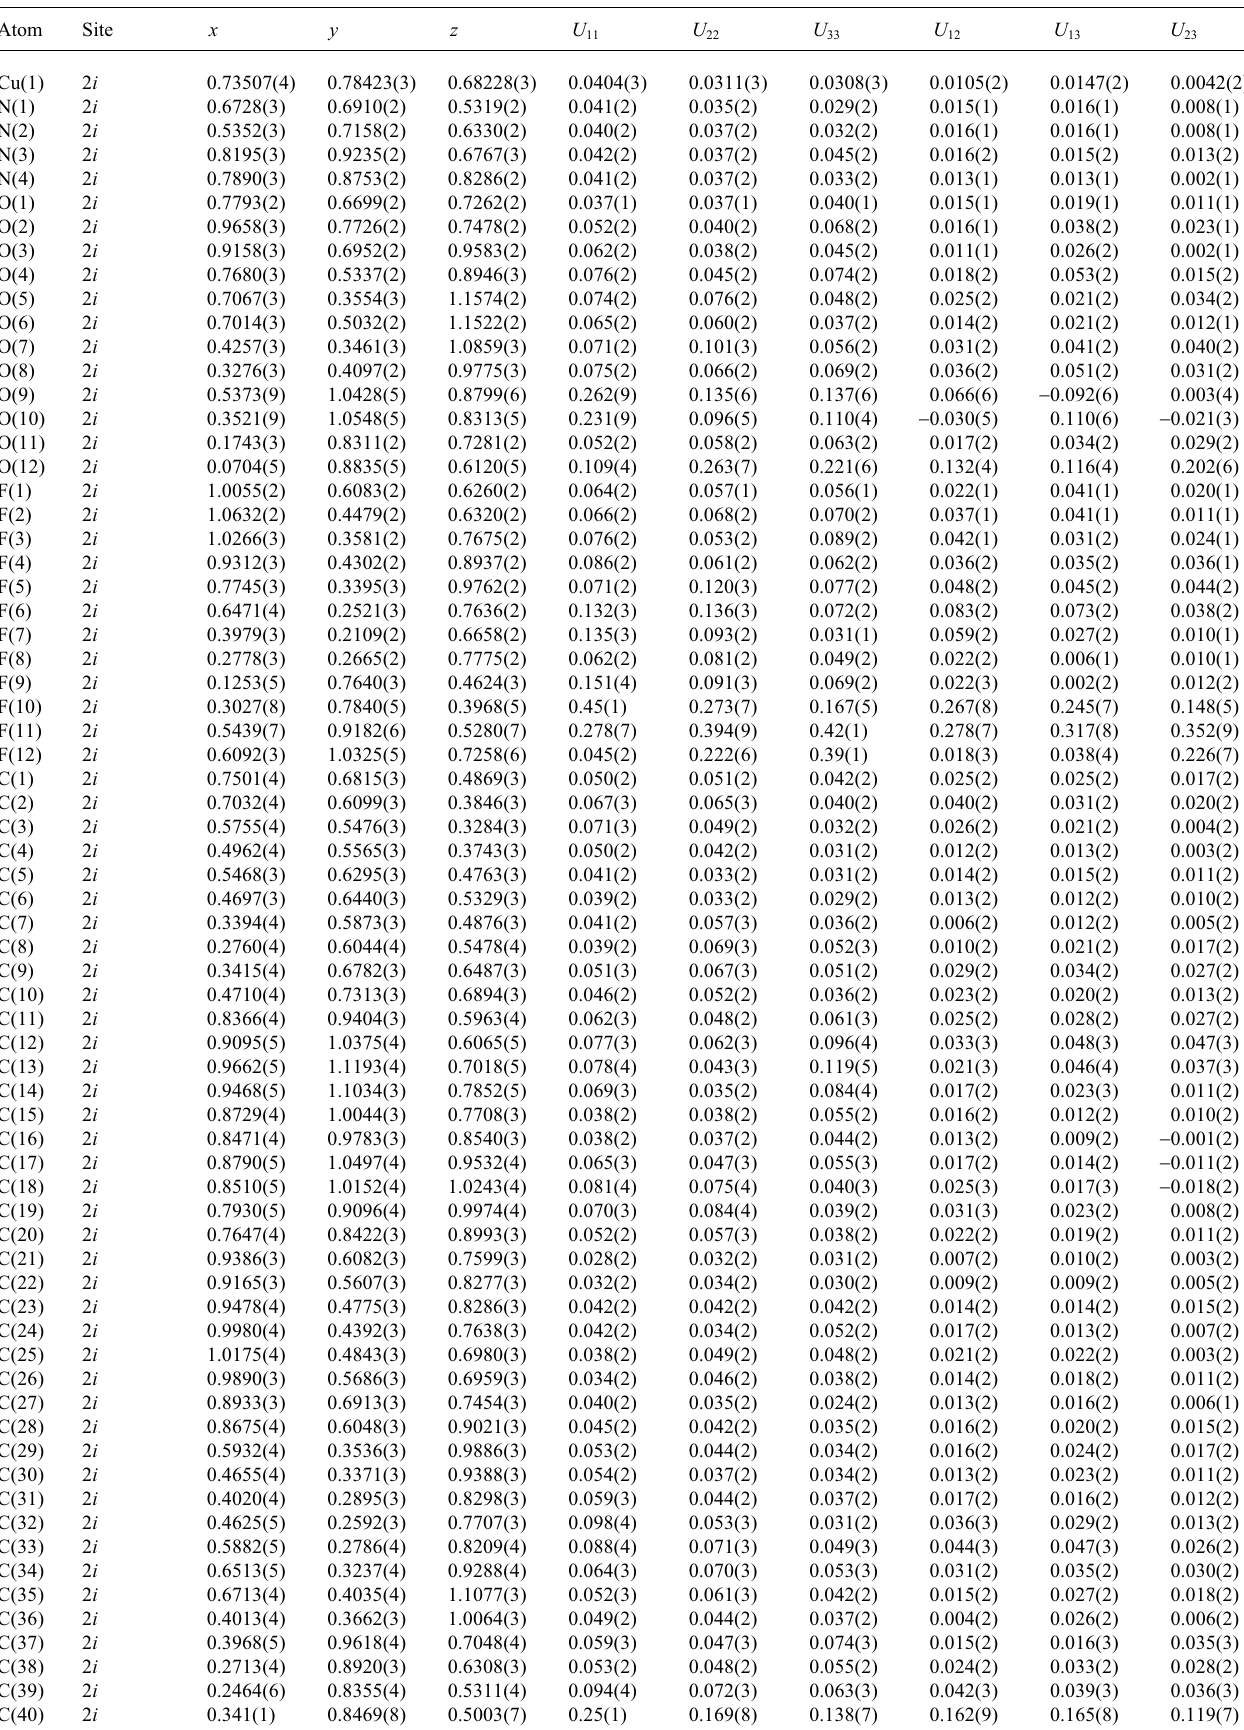
Table 3. Atomic coordinates and displacement parameters (in Å 2 )